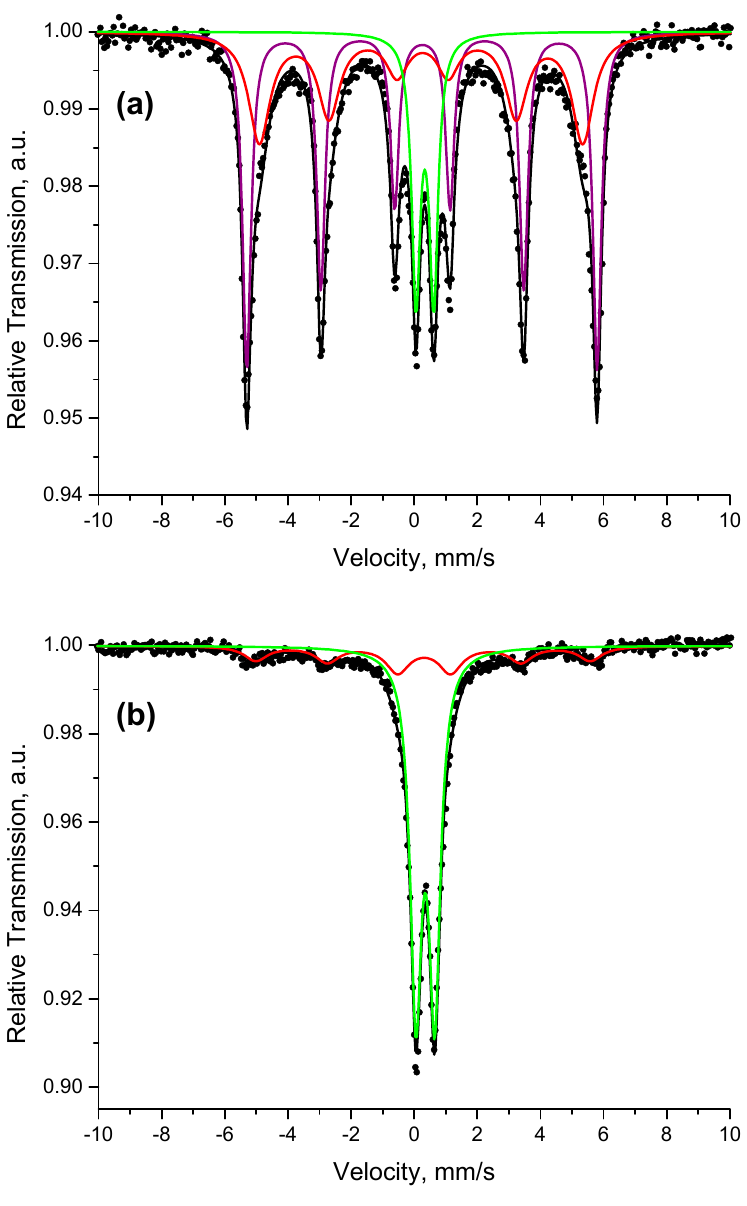
Figure 9. Mössbauer spectra of ( a ) CuFeS 2 and ( b ) CuFeS 2 /TiO 2